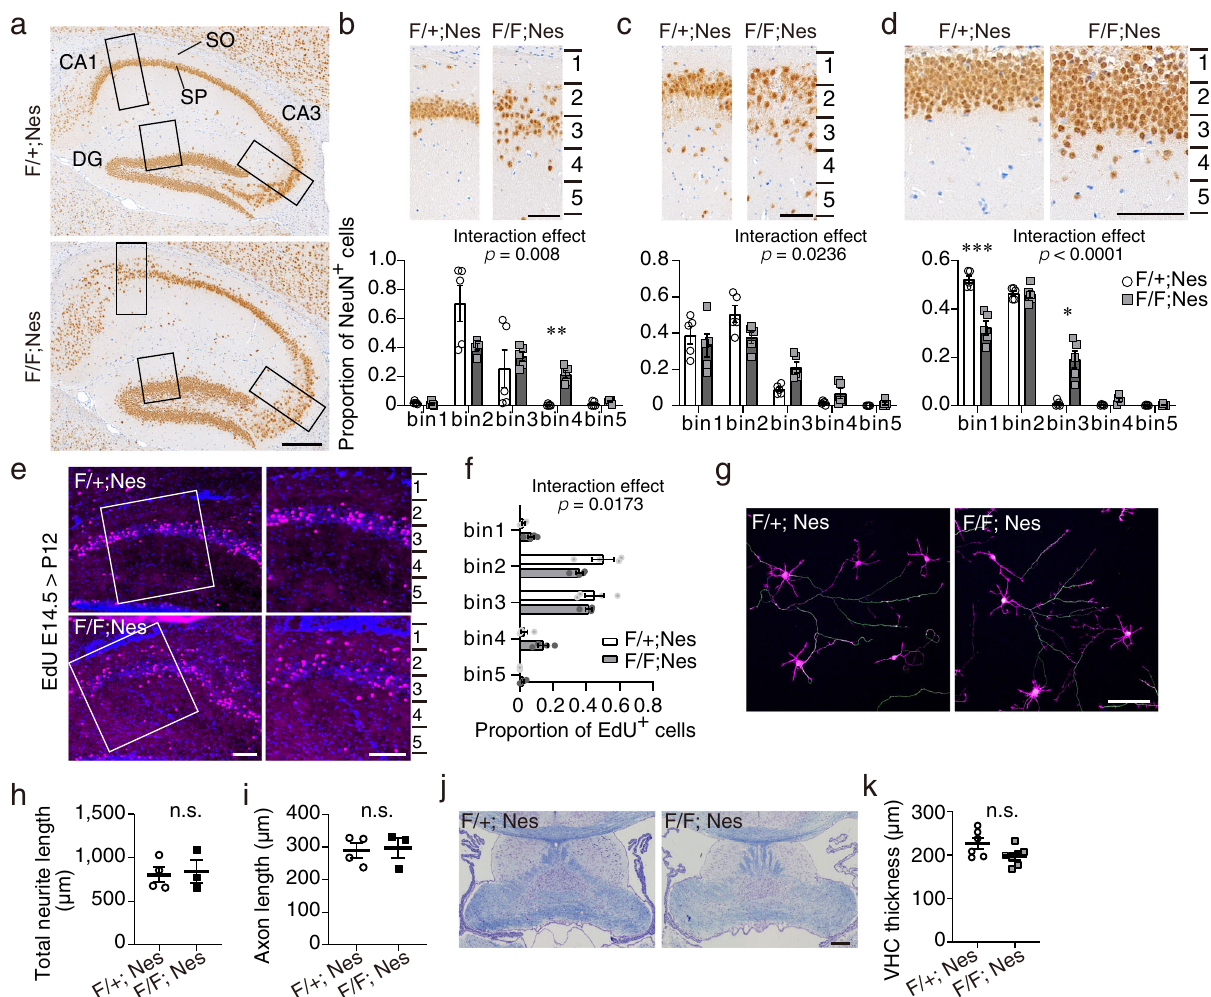
Fig. 4 Ectopic distribution of principal neurons in Rab35 cKO hippocampus. a Immunohistochemistry of sagittal sections of hippocampi of 4-month-old control and Rab35 cKO mice using an anti-NeuN antibody. SP: stratum pyramidale, SO: stratum oriens. Scale bars, 200 μ m. b – d Distribution of NeuN- positive cells in the hippocampal CA1 ( b ), CA3 ( c ), and DG ( d ) regions of control ( n = 4) and Rab35 cKO ( n = 4) mice. Two-way repeated-measures ANOVA with Bonferroni correction; b interaction effect, F (4, 32) = 4.161, p = 0.008; c interaction effect, F (4, 32) = 3.264, p = 0.0236; d interaction effect, F (4, 32) = 25.9, p < 0.0001. e Representative images of P12 hippocampi stained with EdU (magenta) and DAPI (blue). Scale bar, 100 μ m. f Proportion of EdU-positive neurons in the P12 hippocampi of control ( n = 4) and Rab35 cKO ( n = 4) mice. Two-way repeated-measures ANOVA with Bonferroni correction; interaction effect, F (4, 24) = 3.712, p = 0.0173. g Representative images of DIV 3 hippocampal primary neurons stained for p-NF (green) with rhodamine-phalloidin (magenta) and DAPI (blue). Scale bar, 100 μ m. h , i Quanti fi cation of the rhodamine-phalloidin-positive total neurite length ( h ) and p- NF-positive axon length ( i ) of the control and Rab35 -de fi cient primary neurons at DIV 3. At least 50 neurons from four (control) and three ( Rab35 cKO) different cultures were measured. Unpaired Student ’ s t- test; h , p = 0.8204; i , p = 0.8832. j Representative ventral hippocampal commissure (VHC) images of 3-month-old control and Rab35 cKO mice (bregma − 0.35 mm) by Klüver – Barrera staining. Scale bar, 200 μ m. k VHC thickness in control ( n = 6) and Rab35 cKO ( n = 7) mice. Unpaired Student ’ s t -test , p = 0.0695. Data represent mean ± SEM; n.s. not signi fi cant ( p > 0.05); * p < 0.05; ** p < 0.01; and *** p <